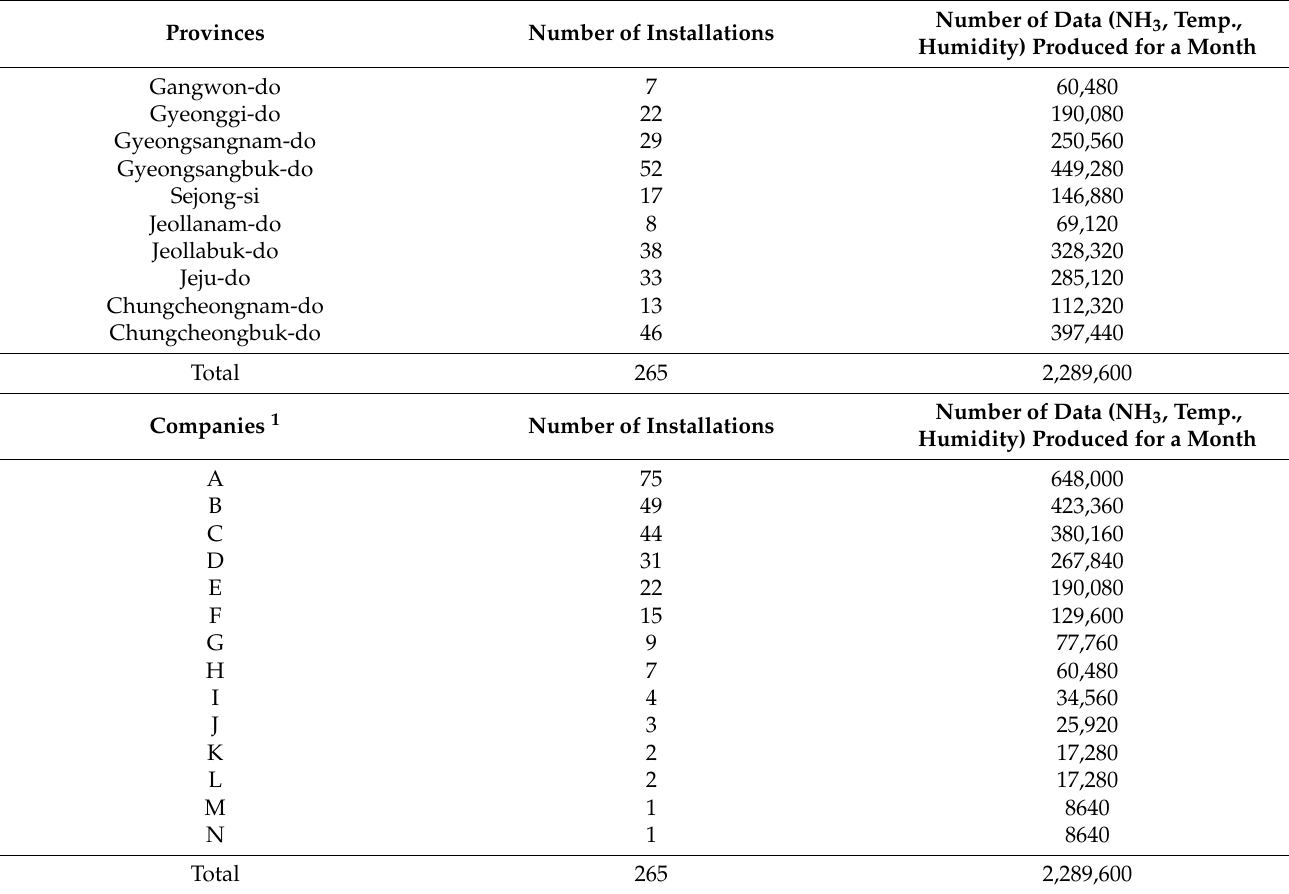
Table 2. The number of installations and data by regions (province) and